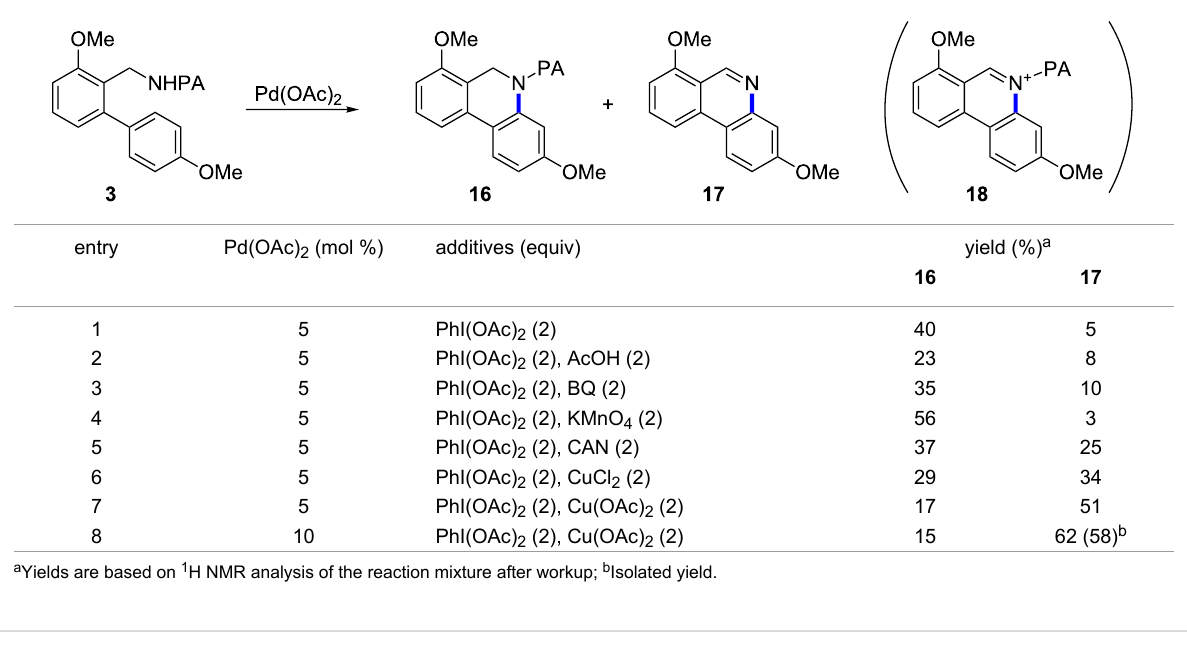
Table 2: Formation of phenanthridine 17 in a single step by Pd-catalyzed intramolecular C–H amination followed by oxidation. All screening reactions were carried out in a 10 mL glass vial on a 0.2 mmol scale.